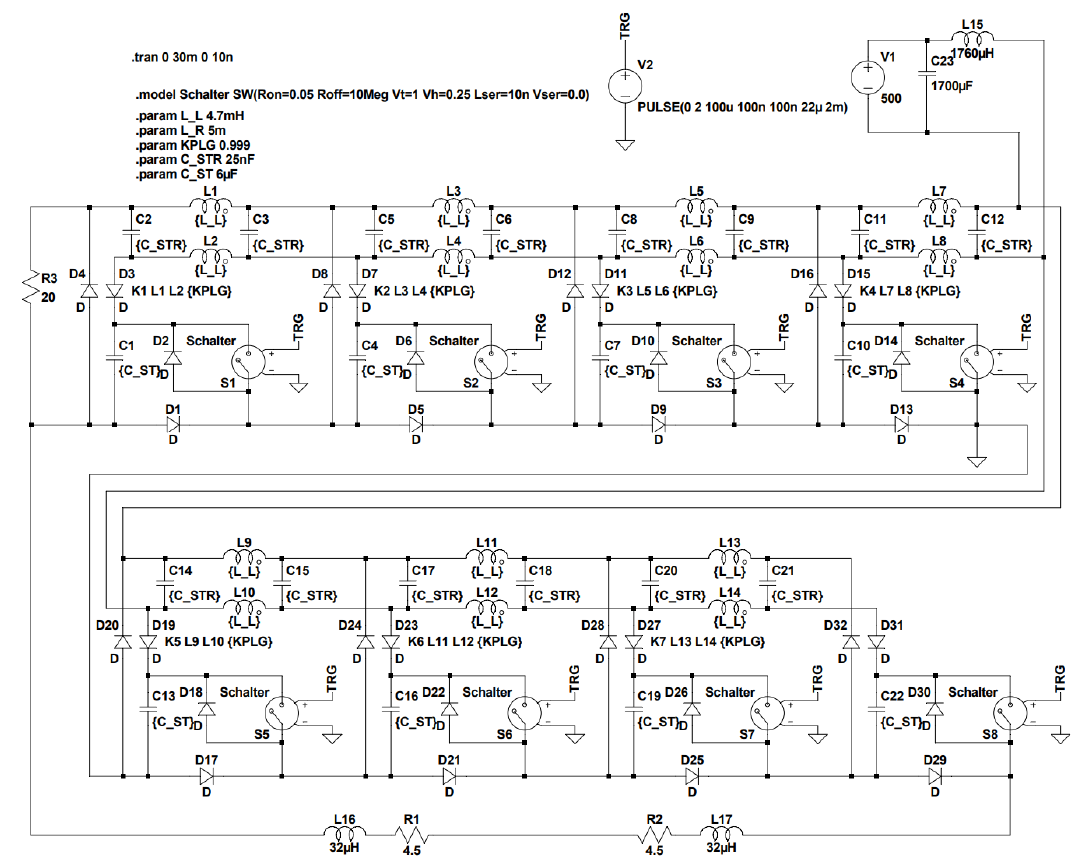
Figure 3. Circuit simulation model for an 8-stage Marx generator with resonant